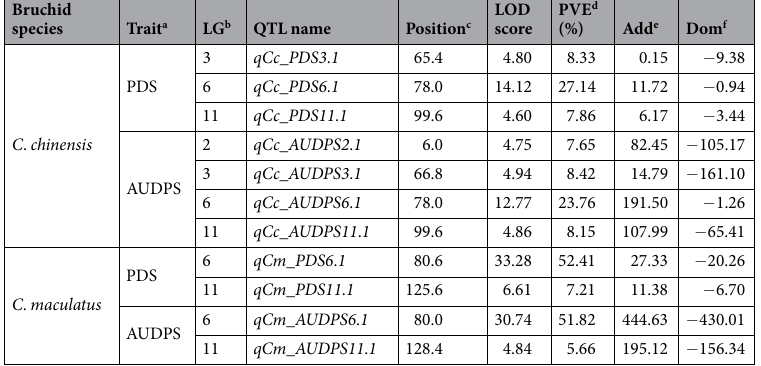
Table 2. QTLs associated with seed resistance to Callosobruchus chinensis and Callosobruchus maculatus detected in the F 2 population of the cross between cultivated zombi pea ‘TVNu240’ and wild zombi pea ‘TVNu1623’. a PDS = percentage of damaged seeds, AUDPS = area under the disease progress stair. b linkage group. c Position (centimorgan) on the linkage map. d Phenotypic variance explained by the QTL. e Additive effect. f Dominant